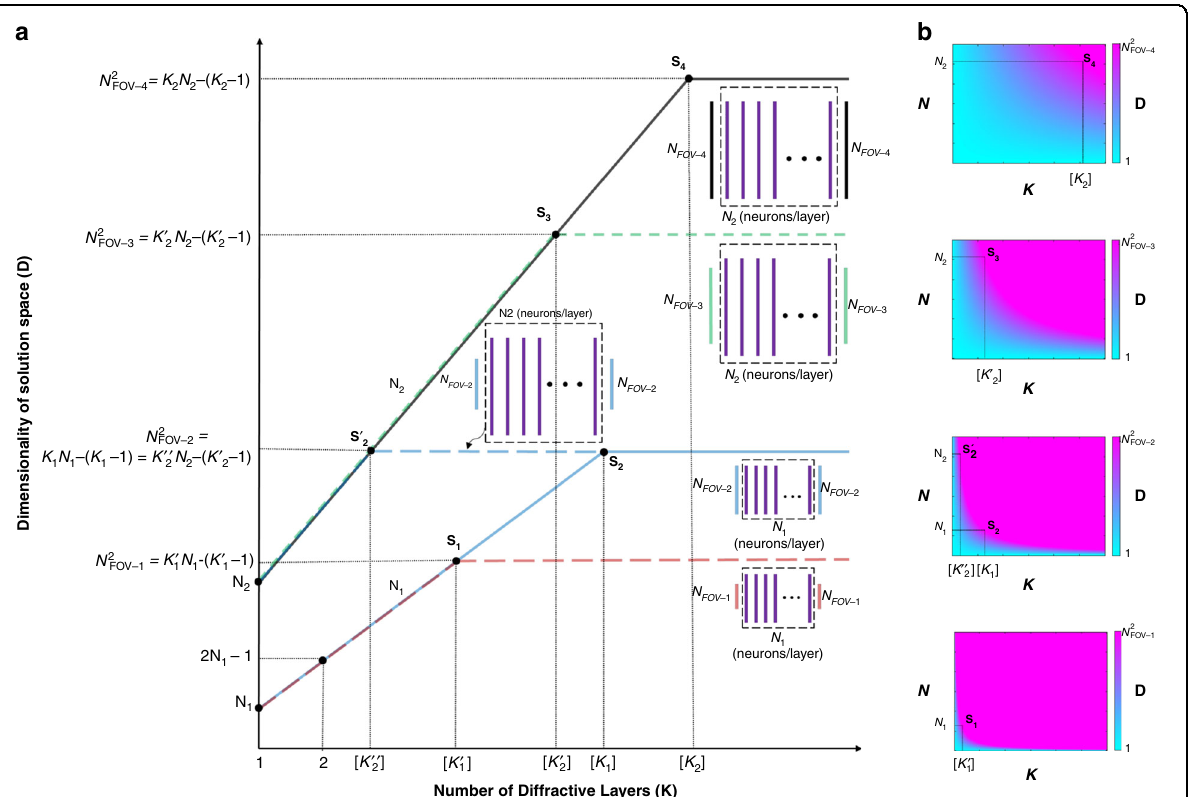
Fig. 2 Dimensionality ( D ) of the all-optical solution space covered by multilayer diffractive networks. a The behavior of the dimensionality of the all-optical solution space as the number of layers increases for two different diffractive surface designs with N = N 1 and N = N 2 neurons per surface, where N 2 > N 1 . The smallest number of diffractive surfaces, [ K s ], satisfying the condition K S N − ( K S − 1) ≥ N i × N o determines the ideal depth of the network for a given N , N i , and N O . For the sake of simplicity, we assumed N i = N o = N FOV − i , where four different input/output fi elds-of-view are illustrated in the plot, i.e., N FOV (cid:7) 4 > N FOV (cid:7) 3 > N FOV (cid:7) 2 > N FOV (cid:7) 1 . [ Ks ] refers to the ceiling function, de fi ning the number of diffractive surfaces within an optical network design. b The distribution of the dimensionality of the all-optical solution space as a function of N and K for four different fi elds-of- view, N FOV − i , and the corresponding turning points, S i , which are shown in a . For K = 1, d 1 ≠ d 2 is assumed. Also see Supplementary Figs. S1 – S3 for some examples of K = 1, 2, and